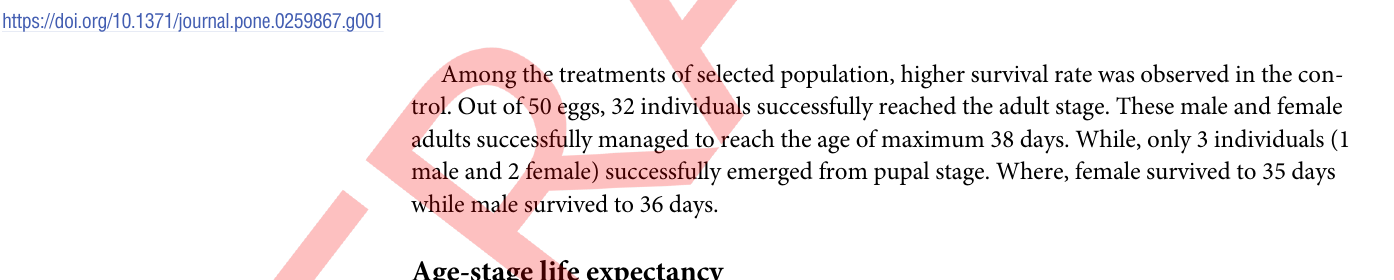
Fig 1. Effect of HaNPV, insecticides and their combinations on survival rate ( S